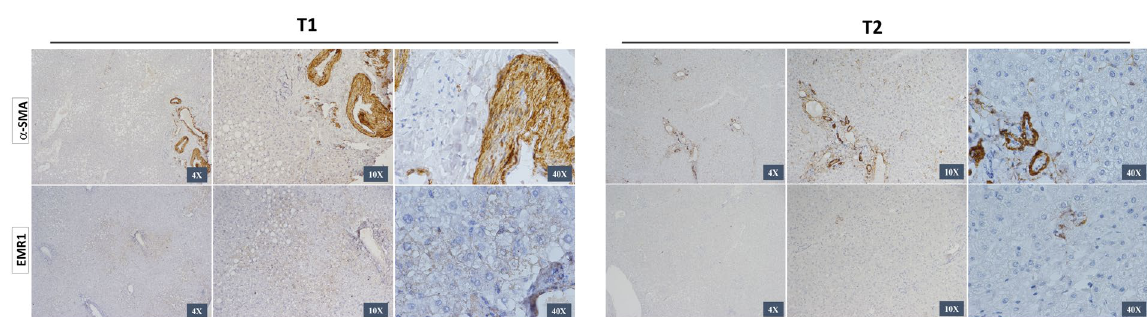
Figure 6. Immunostaining of liver biopsies at the time (T1) and after (T2) bariatric surgery showed Kupffer cell infiltration and myofibroblast formation. Representative images of the immunohistochemical analysis of EGF- like molecule containing mucin-like hormone receptor 1 (EMR1) and alpha-smooth muscle actin ( α -SMA) were performed on paraffin-embedded slides from the T1 and T2 groups. Positive cells for immunostaining are shown in brown. 4 × , 10 × and 40 × objective lenses were used as indicated in each